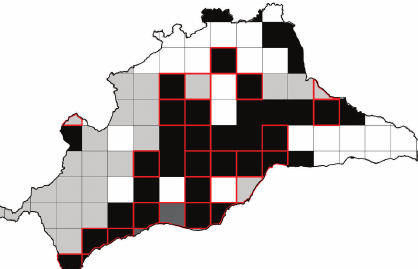
Figure 5: Overlap map. Gray cells indicate areas with overlap values less than 0.4, black cells indicate overlap values between 0.4 and 0.9, and dark gray cells indicate overlap values greater than 0.9. Black cells indicate areas of potential conflict where the red-eared slider could displace the Mediterranean pond turtle. Cells outlined in red show the areas where the red-eared slider is present. Thus, black cells outlined in red indicate current areas of high risk for the Mediterranean pond turtle, and black cells without a red outline indicate areas of high risk for the Mediterranean pond turtle in the